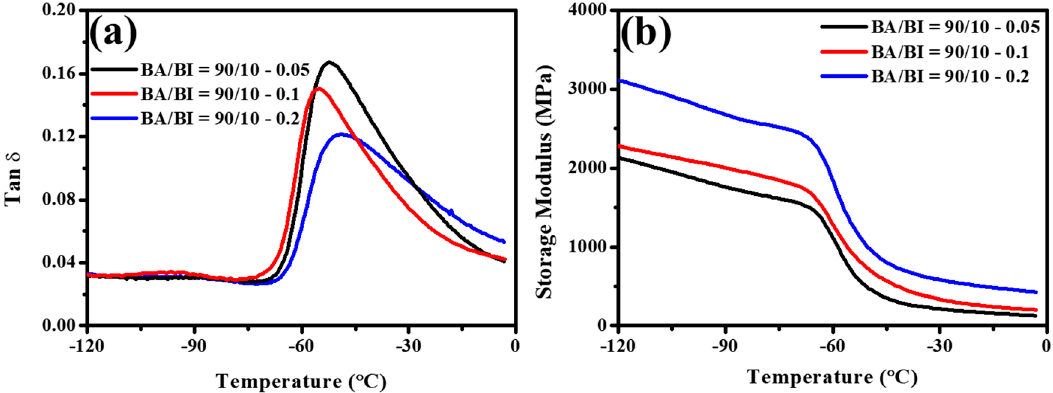
Figure 13. DMA results for ( a ) Tan δ and ( b ) storage modulus of PBABI copolyesters at different concentrations of BTCA.